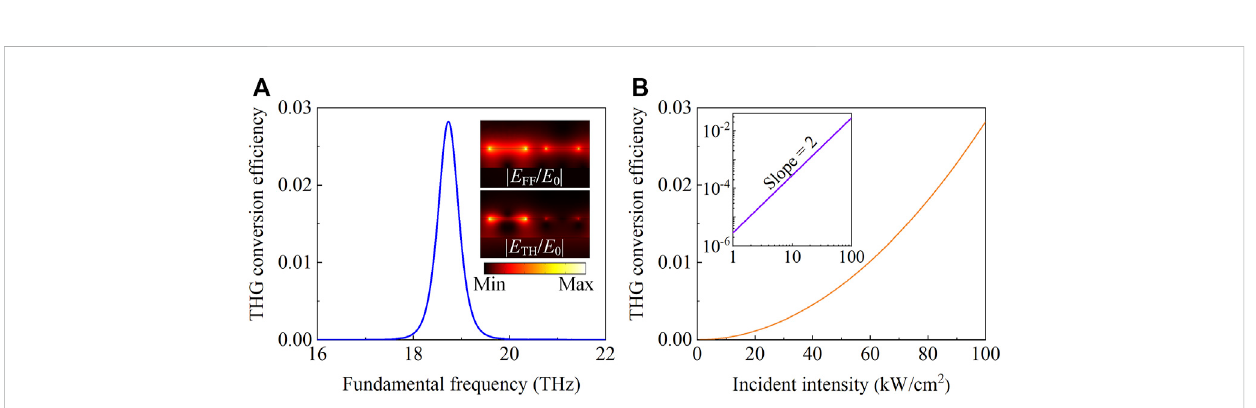
FIGURE 4 (A) THGconversionef fi ciencyagainstthefundamentalfrequencyfortheincidentwave.Theinsetsaretheenhancedelectric fi elddistributionsatthe fundamental frequency of 18.7 THz and the third-harmonic frequency of 56.1 THz. (B) THG conversion ef fi ciency varies with intensity for the incident wave. The inset iscorresponding to thelog – log plot.The parametersare p = 300 nm, w 1 =100 nm, w 2 =90 nm, h 1 = 52 nm, h 2 = 1,350 nm, E f 1 = 0.2 eV, and E f 2 = 1